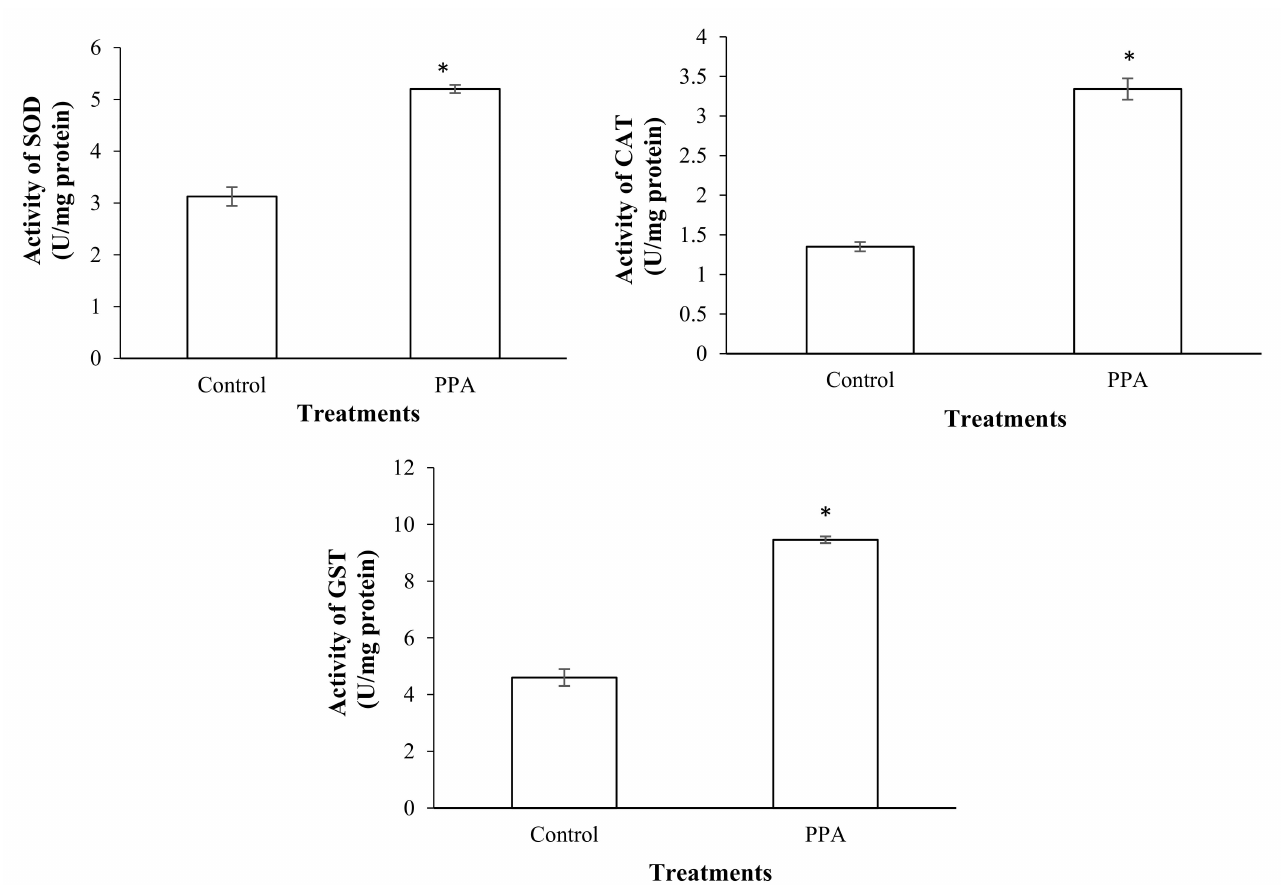
Figure 4. Activities of antioxidant enzymes in control and PPA-treated adults of Sitophilus oryzae : superoxidase dismutase (SOD); catalase (CAT); glutathione s-transferase (GST). Statistical differences have been marked by asterisks ( t -test, p ≤ 0.05). * indicate significant